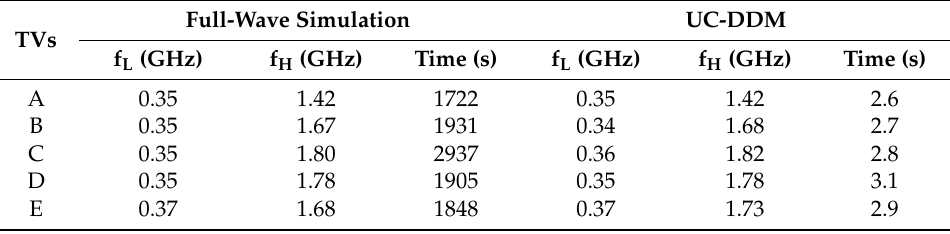
Table 2. PPN suppressions and computation time of the UC-DDM and the full-wave